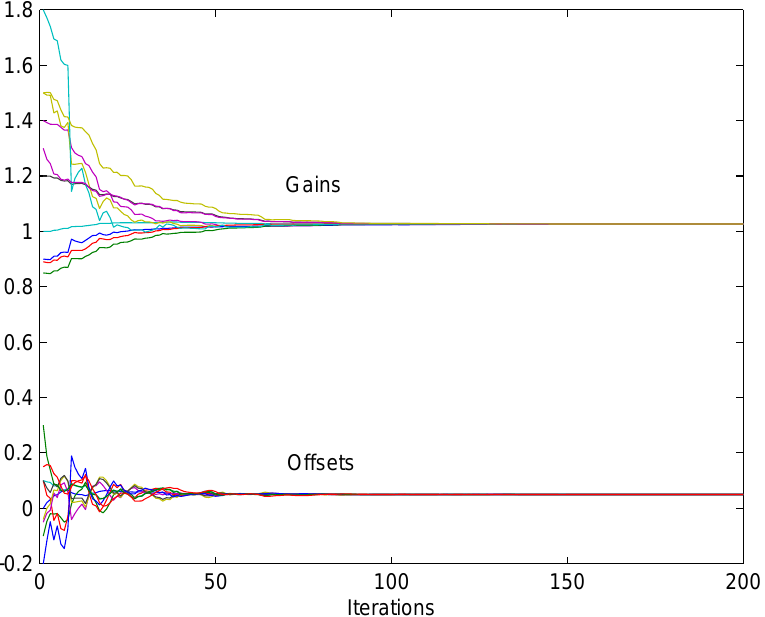
Figure 3. Noiseless synchronous algorithm without references: convergence to consensus is achieved for corrected gains and corrected